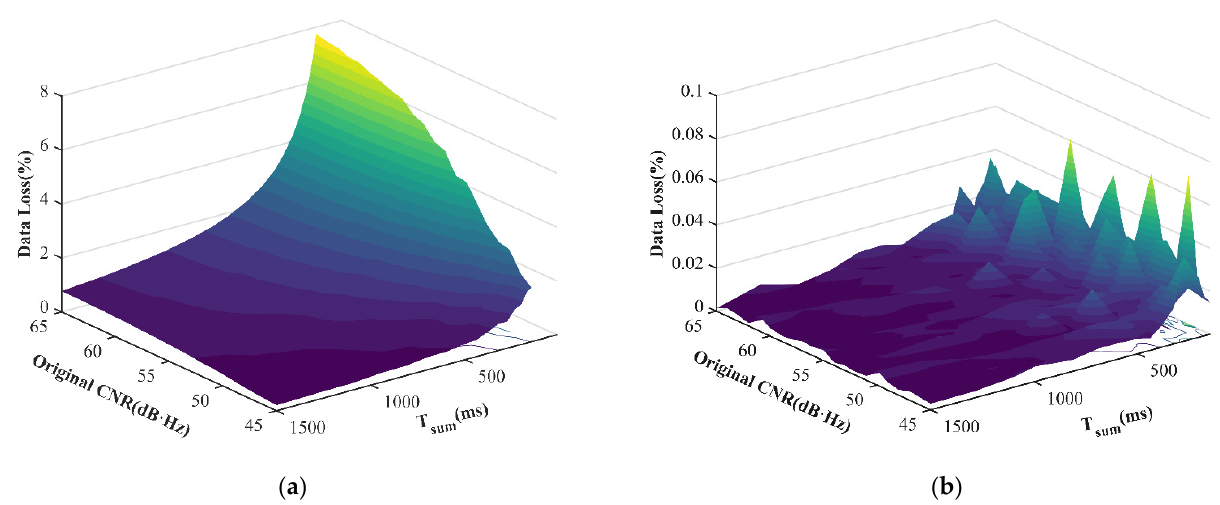
Figure 16. The data loss under different signal characteristics. ( a ) The performance of the traditional anti-jamming algorithm. ( b ) The performance of the robust anti-jamming algorithm.